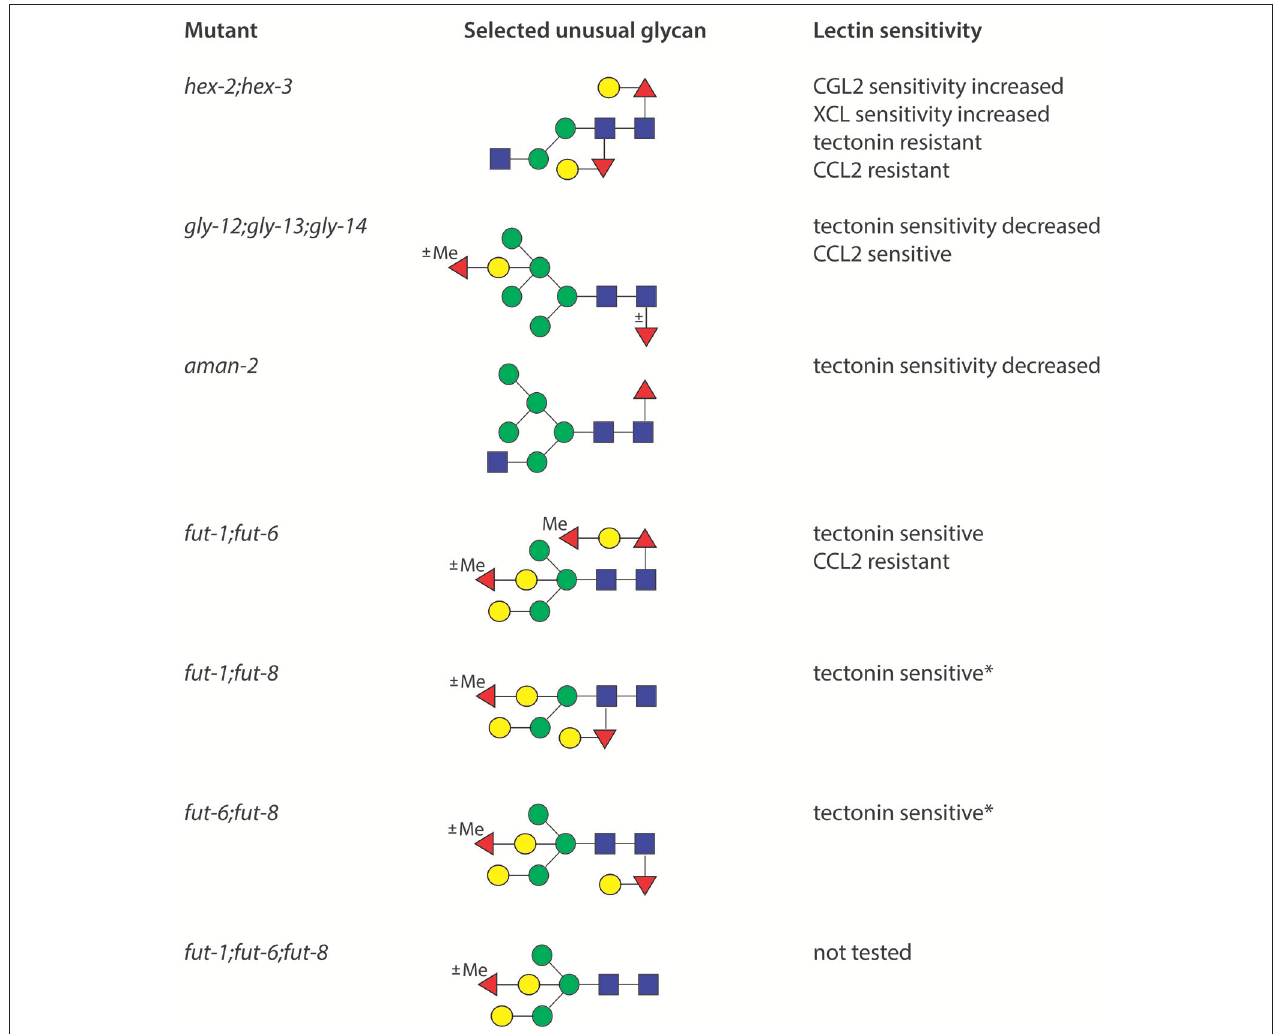
FIGURE 3 | Correlations of N-glycan structure and lectin sensitivity. Example glycans from double and triple mutants analyzed in our laboratory are shown as well as a summary of data from the Aebi/Künzler group on their sensitivity to nematoxic carbohydrate binding proteins isolated from fungi; CCL2 and CGL2 from Coprinopsis respectively bind core α 1,3-fucose and GalFuc, tectonin from Laccaria bicolor to methylated sugars and XCL from Xerocomus chrysenteron to GlcNAc. Note that also various single mutants ( bre-1 , ger-1, galt-1, fut-1, fut-6, fut-8, gly-12, gly-13, gly-14, and gly-20 ) are also displaying sensitivity or resistance toward Aleuria aurantia lectin (AAL), CGL2 and CCL2, while it is assumed that all double mutants with a defective fut-8 gene (marked with an asterisk, *) are also CGL2 resistant like the single